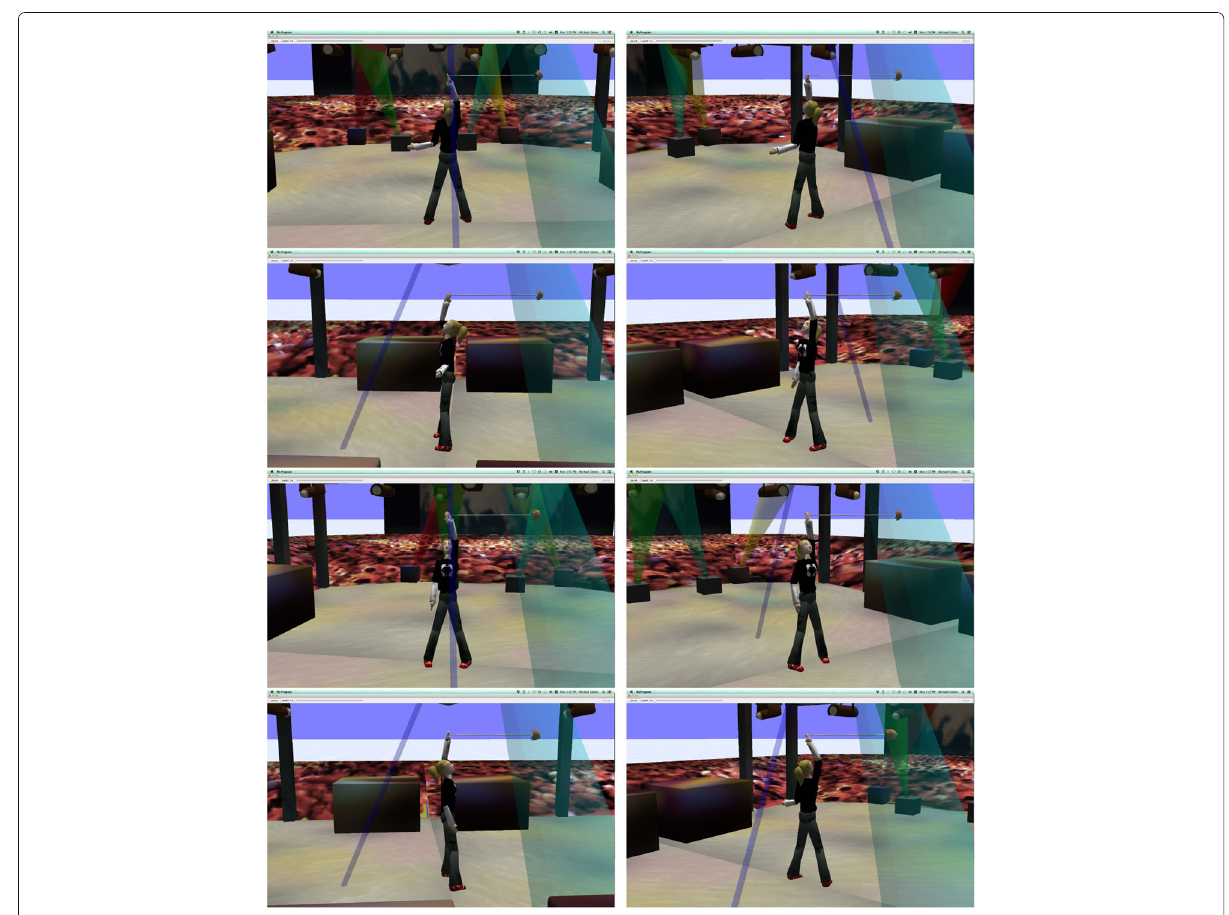
Fig. 17 Phase perturbation of projected affordance: As the perspective changes (and the simulated projected prop is moved to opposite hand), phase of the projected affordance is adjusted to maintain visual alignment, and so remains pointed to the right in this artificial